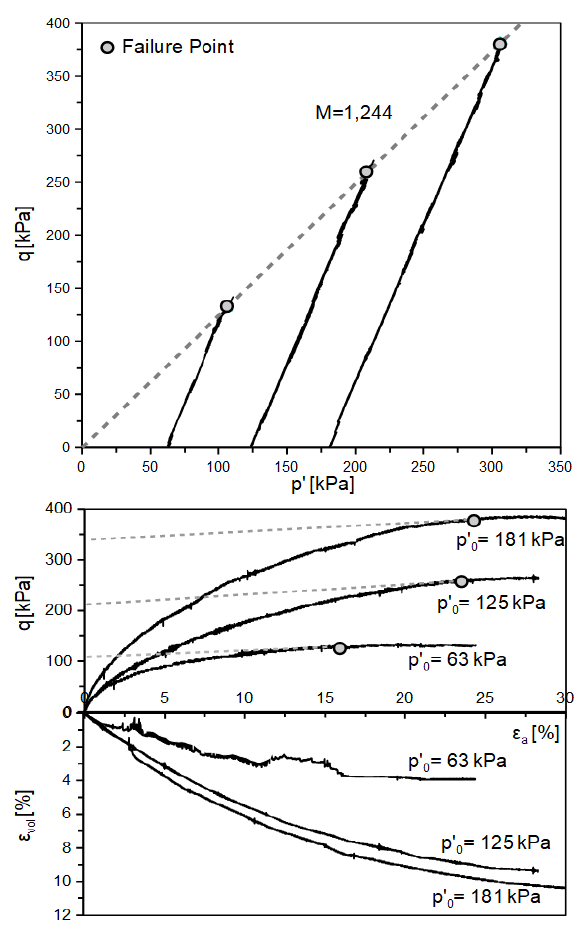
Figure 4: The results of CD tests on organic silt.